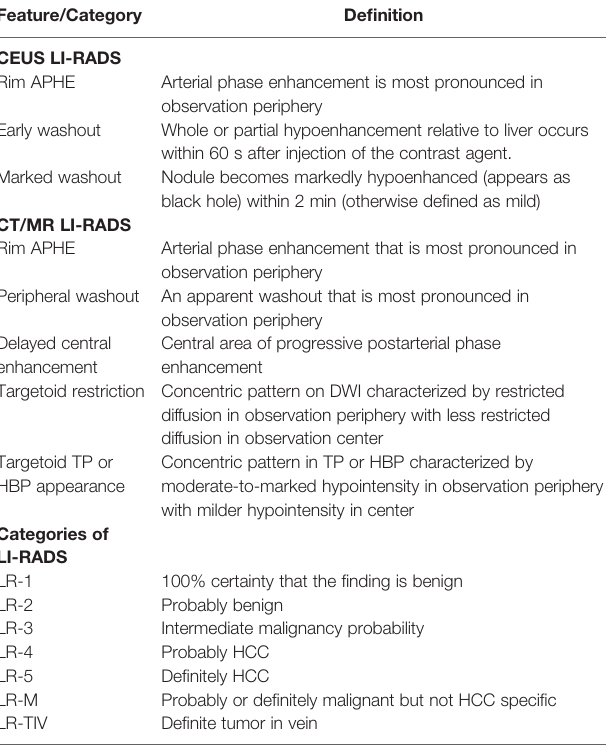
TABLE 1 | Explanation of Each Imaging Feature for LR-M and Category.